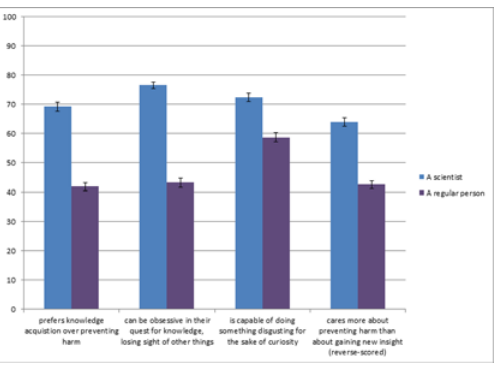
Fig 4. Evaluations of motivational trade-offs of scientists and control targets, Study 10. All means differ at p < .001. Error bars show standard errors of the